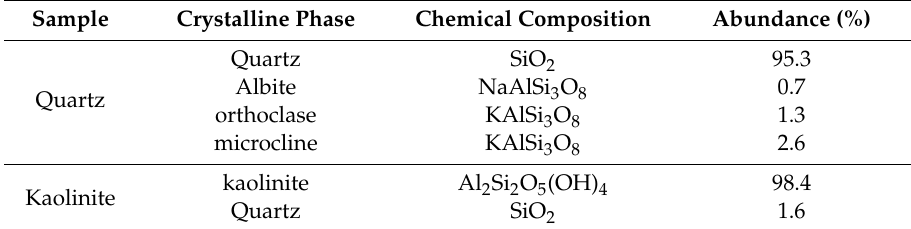
Table 1. Composition of the mixture of quartz and kaolinite used to simulate the artificial mine tailings. Sample Crystalline Phase Chemical Composition Abundance (%) Quartz Quartz